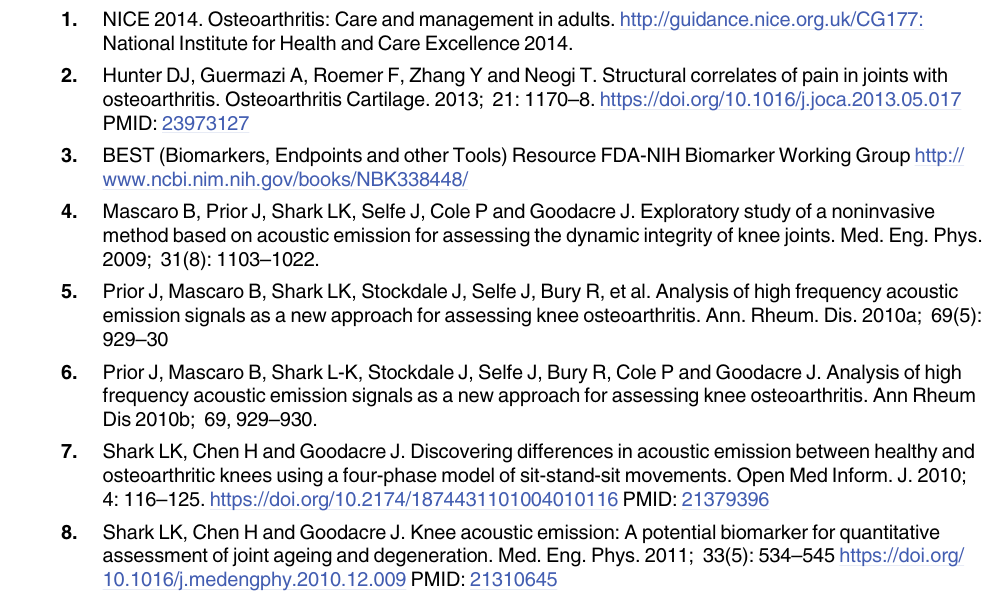
S2 Fig. The four phases of the sit-stand-sit movement protocol.